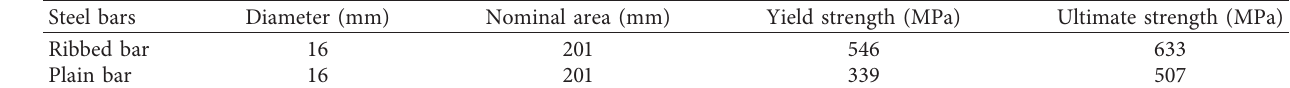
Table 3: Properties of the steel bars.